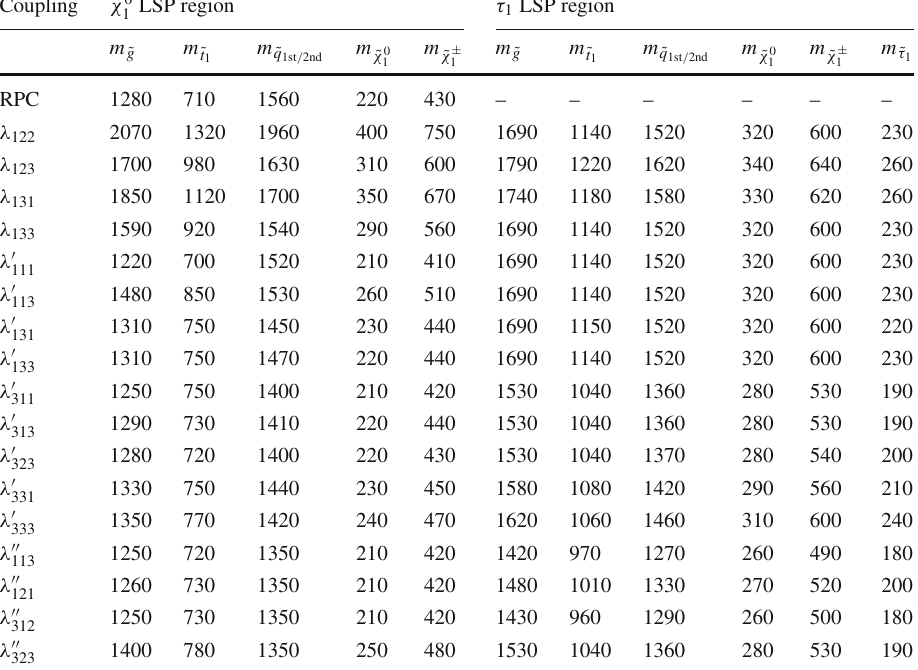
on the particle spectrum in GeV. The mass bounds for each RPV coupling are obtained from the most conservative points that appear in the M 0 – M 1 / 2 planes of Figs. 11, 12, 13, 14, 15 and 16 from Sect. 6. In the RPC case there are no ˜ τ -LSP